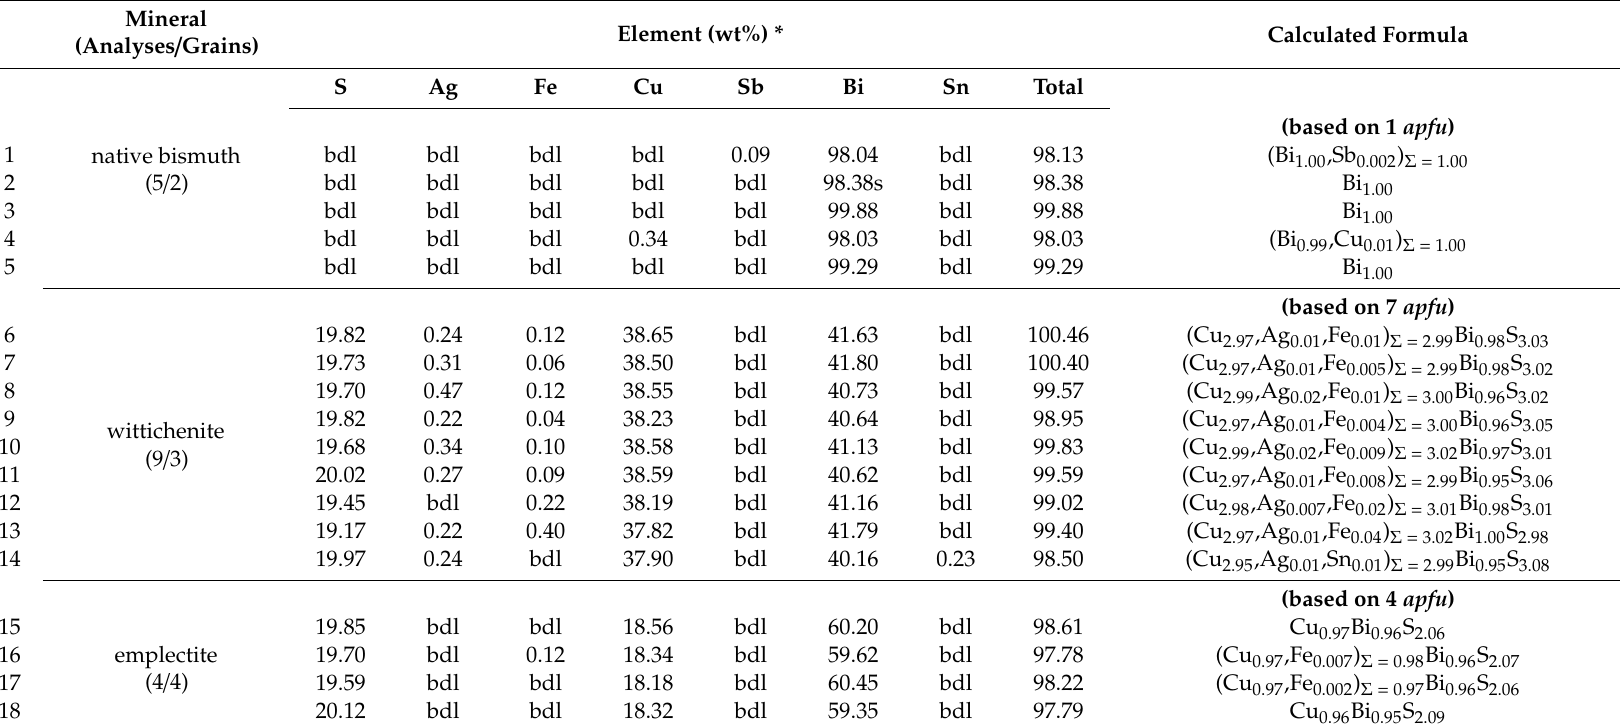
Table 2. Quantitative chemical data (wt%) for native bismuth, wittichenite, and emplectite from the Blidar Contact orebody.